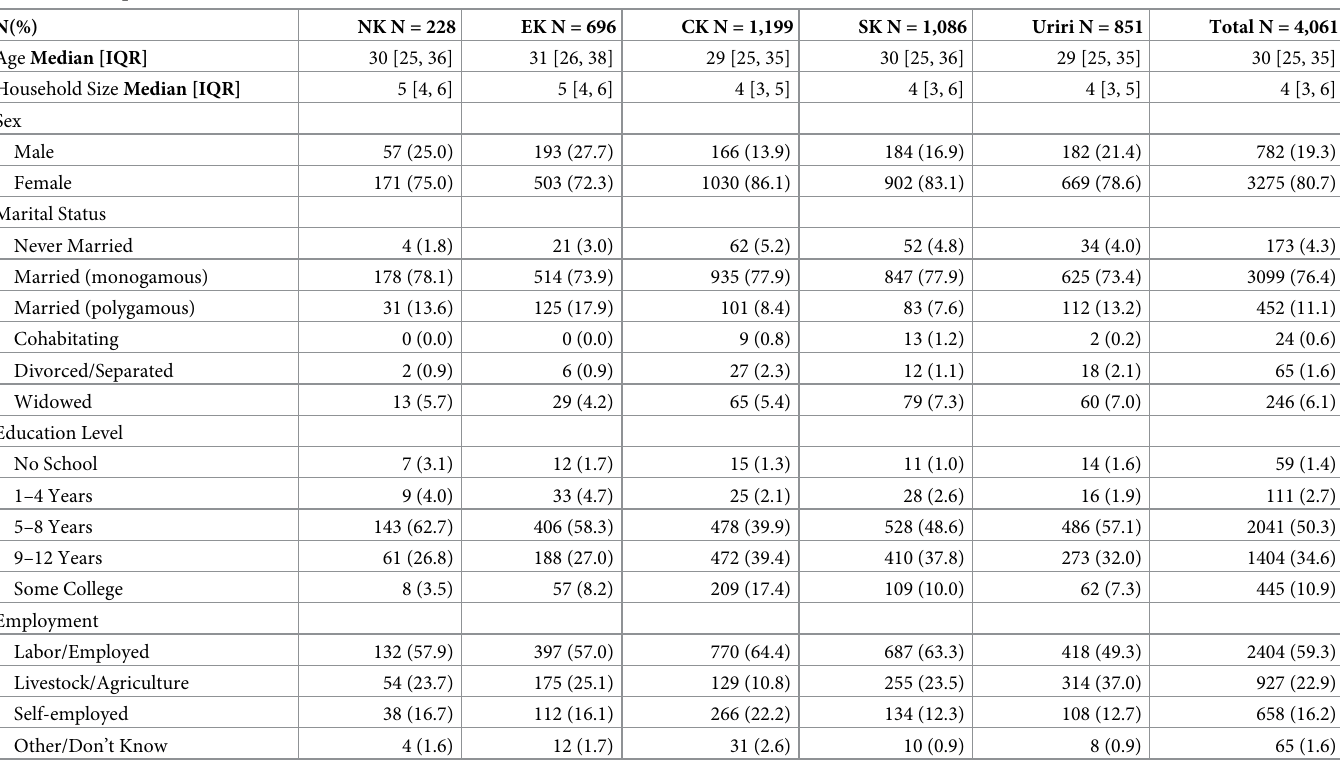
Table 2. Descriptive statistics.